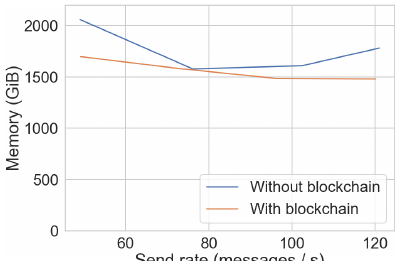
Figure 10. Memory comparison depending on the send